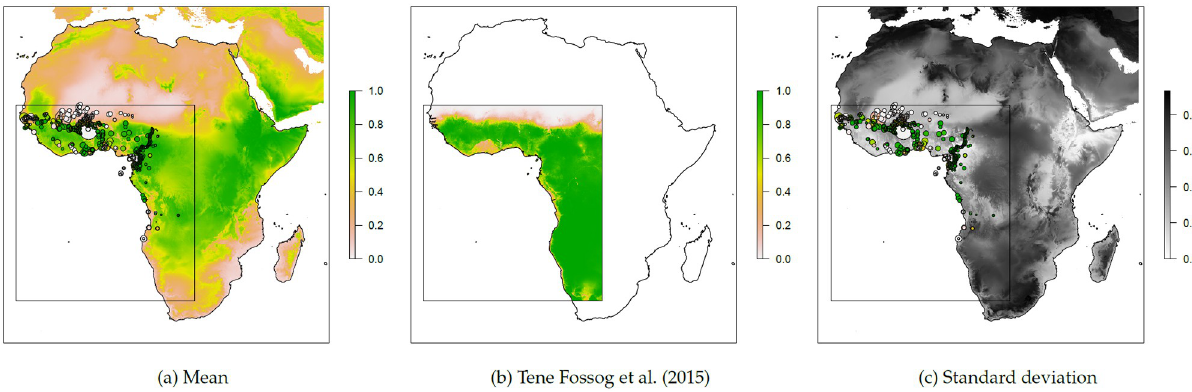
Fig 2. Summary statistics of relative abundance based on 100 neural network model runs. Mean relative abundance (a) is given as the proportion of An. gambiae s.s. (as opposed to An. coluzzii ) in the local mosquito population, with low proportions given as white and high proportions as green. Circles represent data points on which the model is trained, filled with colour representing the proportion measured at the given site. The corresponding results from [27] are given for the purposes of direct comparison (b). The standard deviation of relative abundance (c) between model runs is shown in greyscale, with white as low and black as high uncertainty of model estimates at a given site. The rectangle denotes the area of study used in [27]. Note that the relative abundance estimates cover areas where neither subspecies are expected to exist (see later figures). Base map from Natural Earth: https://www.naturalearthdata.com/downloads/10m-physical-vectors/10m-coastline/.